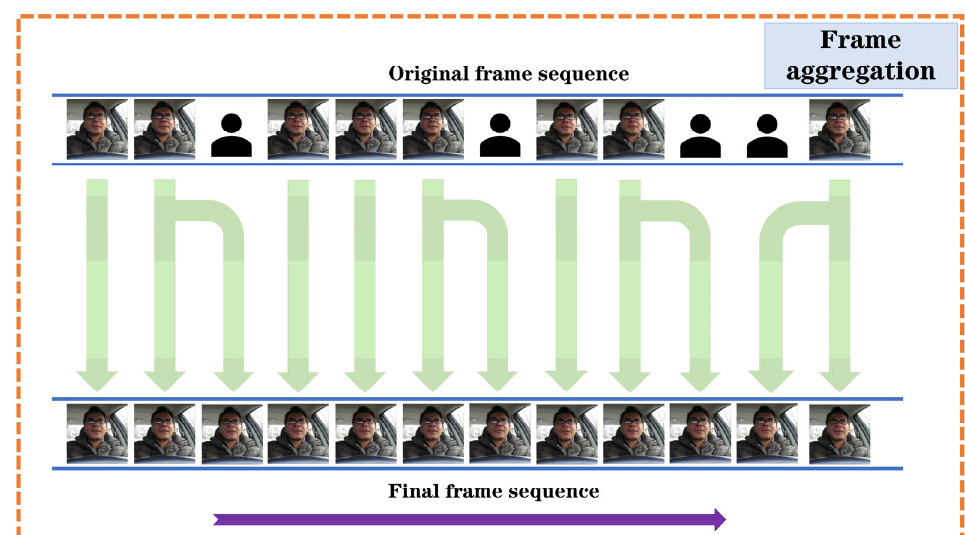
Figure 3. Schematic diagram of frame aggregation strategy.